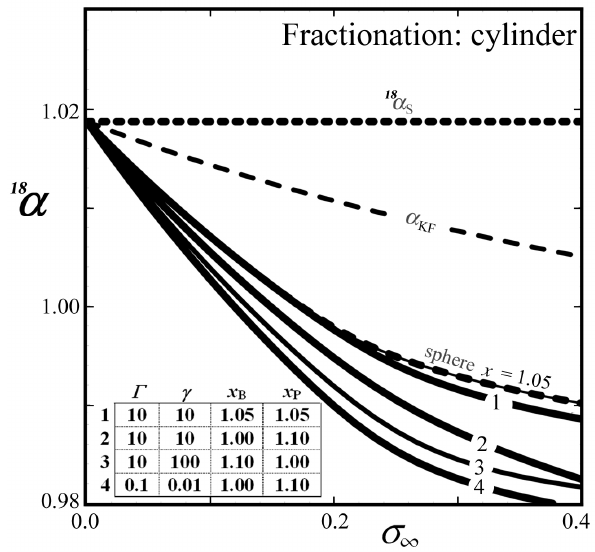
Fig. 3. Fractionation coefficient 18 α for fully facetted cylindrical crystals at T =− 20 ◦ C. All cases had the same average x , the same volume (giving Z V = 300 for the equivalent sphere) and growth pa- rameters σ 1 = 0 . 5 and n = 10 on the fastest-growing face (same as beaded curves in Fig. 2). Cases 1–3 are columnar crystals with 0 = 10, whereas case 4 is a tabular crystal with 0 = 0 . 1. Crystals in cases 1 & 2 grow under steady-state growth, whereas 3 & 4 grow with increasing shape anisotropy. For cases 2–4, switching values of x B and x P would yield curves above that shown for the